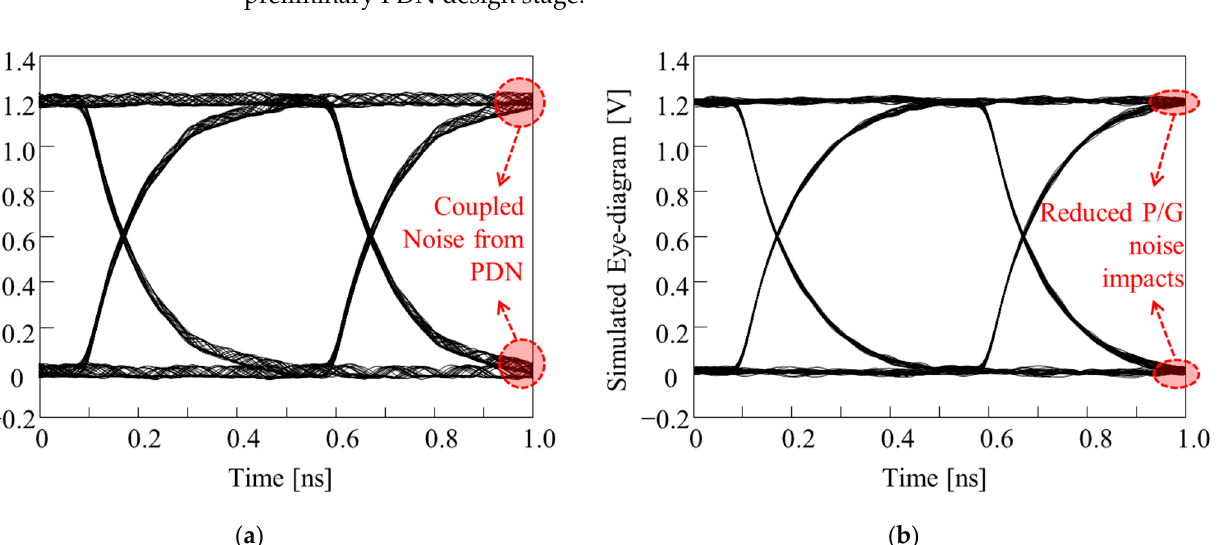
Figure 12. Graphical depiction of the simulation scenario. Aggressor channel escaping the package or interposer induces noise in the PDN. The noise propagates and couples to the victim channel. Eye diagrams of the victim channel are compared without and with noise suppression structures.